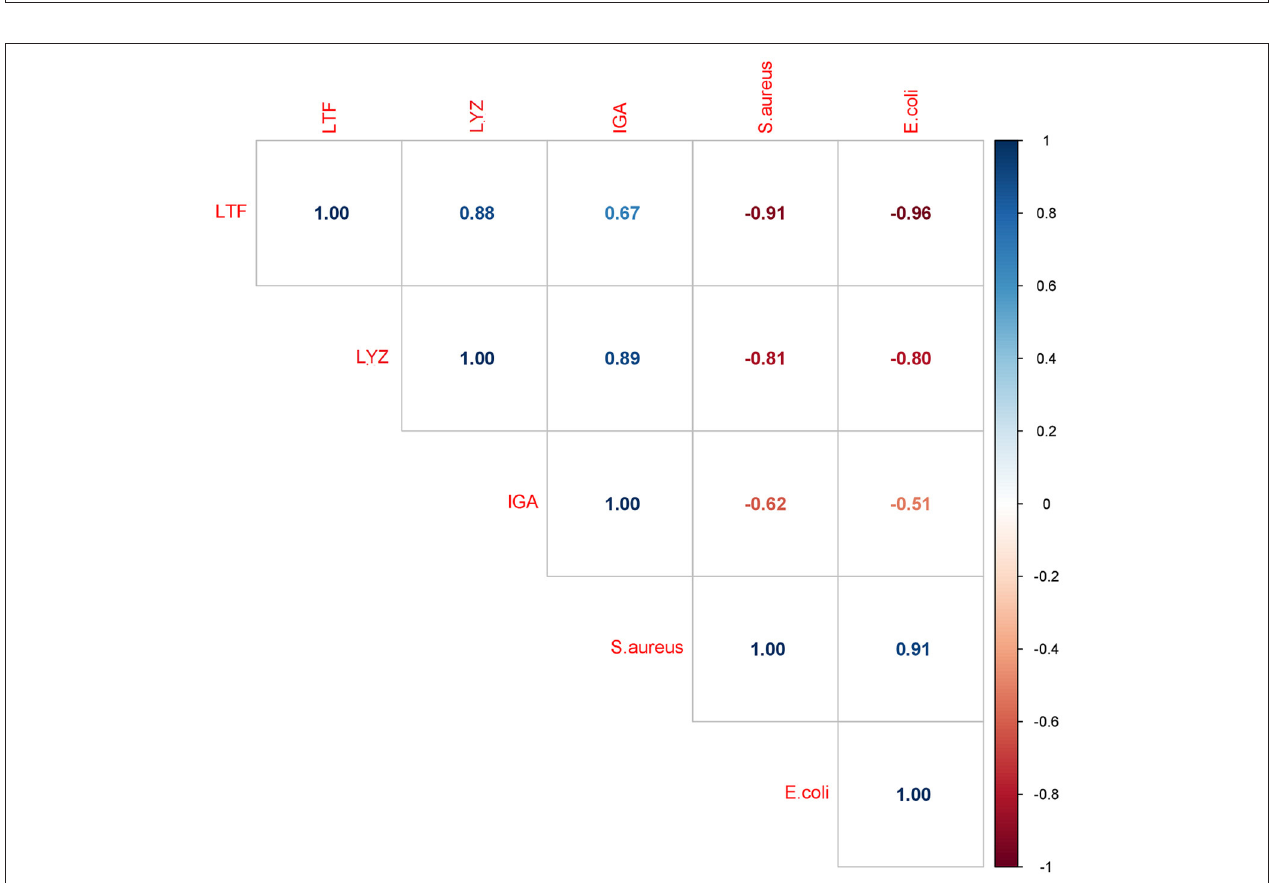
FIGURE 8 | Correlation matrix of bacterial growth rates and IgA, LTF and LYZ iBAQ intensities. Each box includes a Pearson correlation coefficient ( r value).